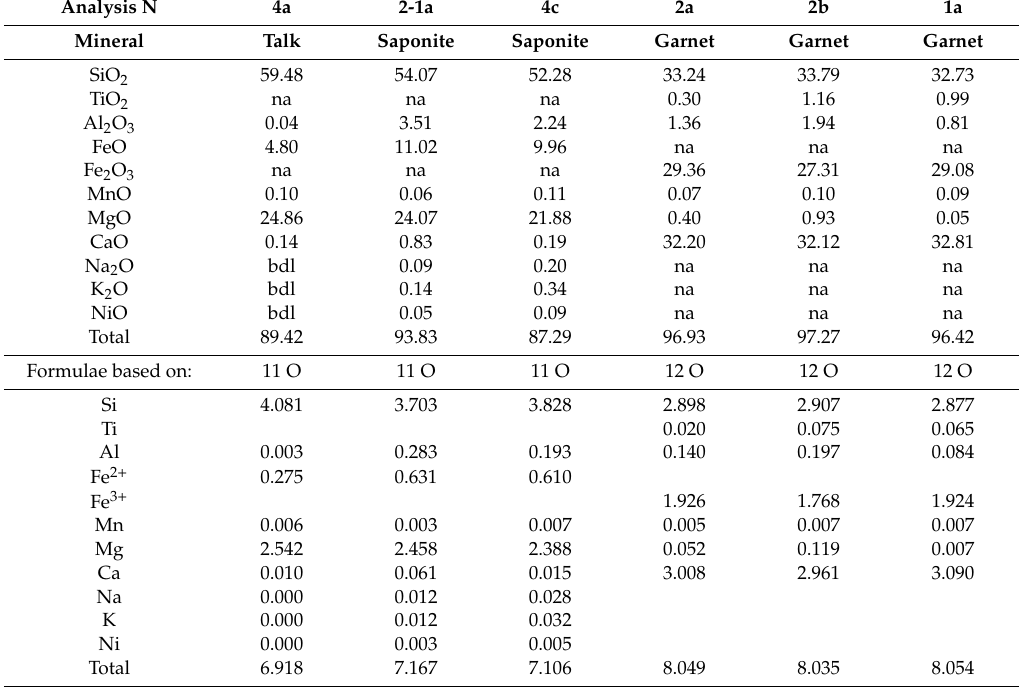
Table 3. Representative chemical compositions (wt.%) and mineral formulae (apfu) of talk, saponite and garnet from the Vinoren aillikite.